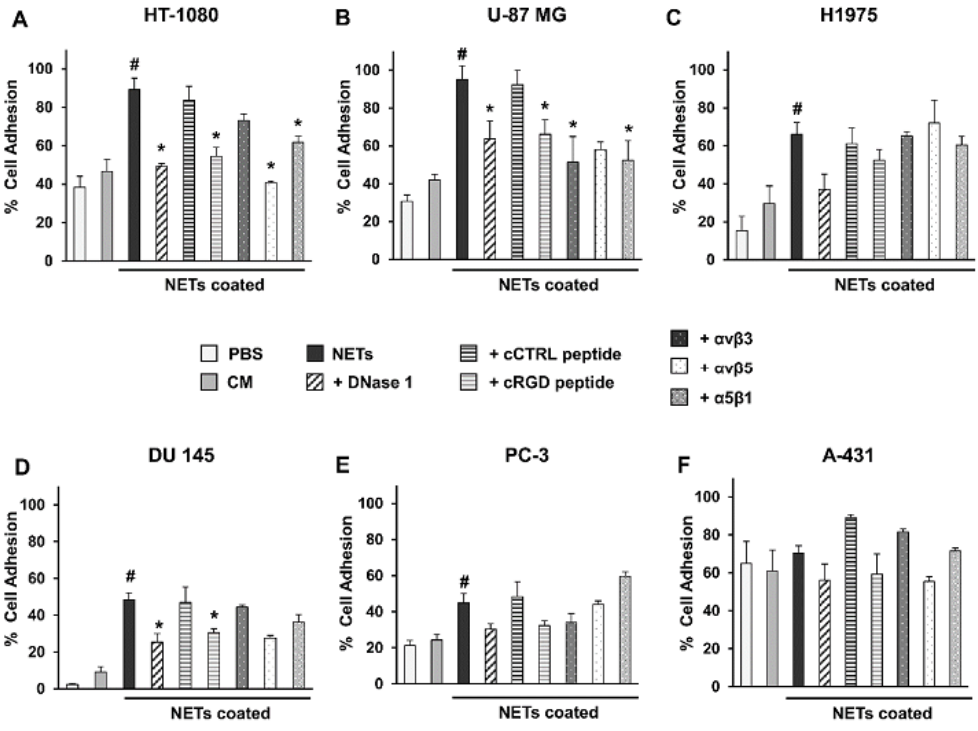
Figure 3. ( A – F ) Adhesion of different cancer cell lines to NETs. Isolated NETs were used as an adhesion substrate to coat multi-well plates, whereas phosphate buffered saline (PBS) or conditioned medium (CM) from unstimulated neutrophil-like cells were used as negative controls. Cells were then added to each well in serum-free conditions and allowed to adhere for 1 h at 37 ◦ C in the absence or presence of DNase 1, cyclic control peptide (cCTRL), cyclic RGD peptide (cRGD) and the blocking antibody recognizing the selected integrin. After removal of non-adherent cells and a gentle washing, adherent cells were detached and counted. Results are expressed as percentage of adherent cells compared to the total number of added cells (mean ± SE). Statistical significant differences versus negative controls (PBS and CM) are indicated by the symbol # ( p < 0.05), whereas versus NETs by the symbol * ( p <